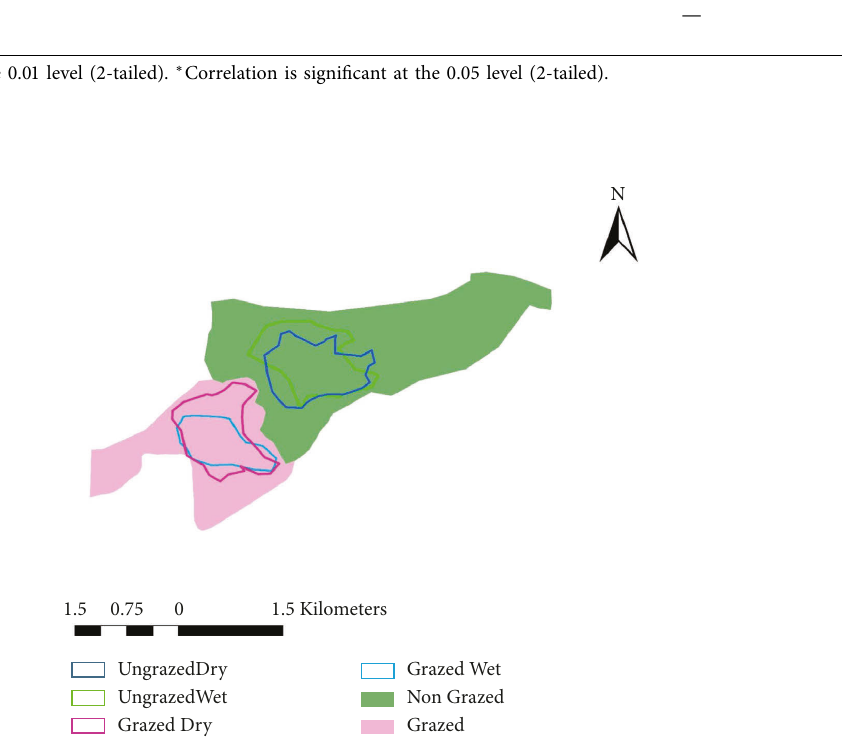
Figure 7: Depiction of the 95% minimum convex polygon (MCP) of seasonal home ranges of the study groups in grazed and non-grazed